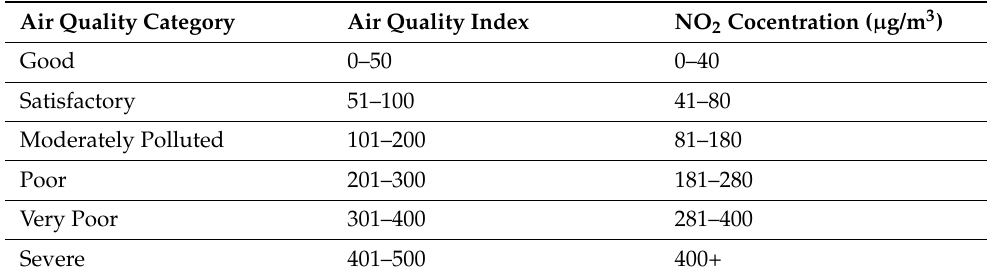
Table 3. AQI categories and concentration ranges for India (source: